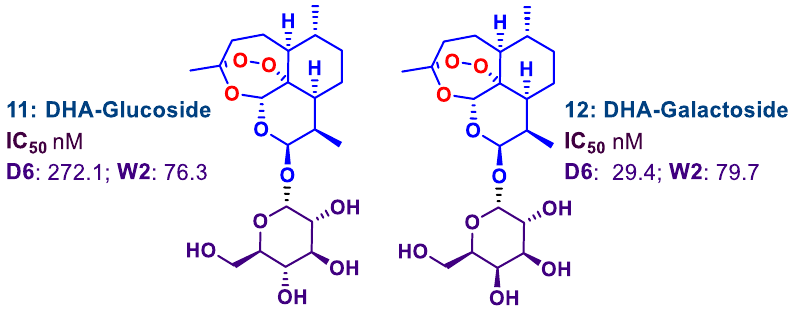
Figure 3. O -Glycosylated DHA derivatives and antimalarial activities against Plasmodium falciparum ( Pf ) D6 and W2 strains in vitro; cf. artemisinin 1 : IC 50 D6 10.4 nM; W2 2.4 nM.